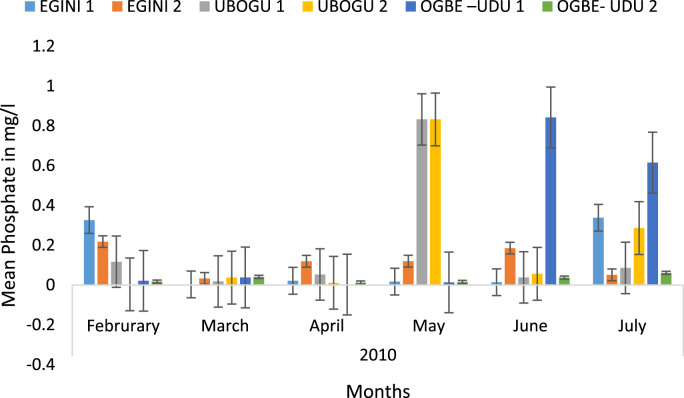
Mean Temporal and spatial variations in phosphate.